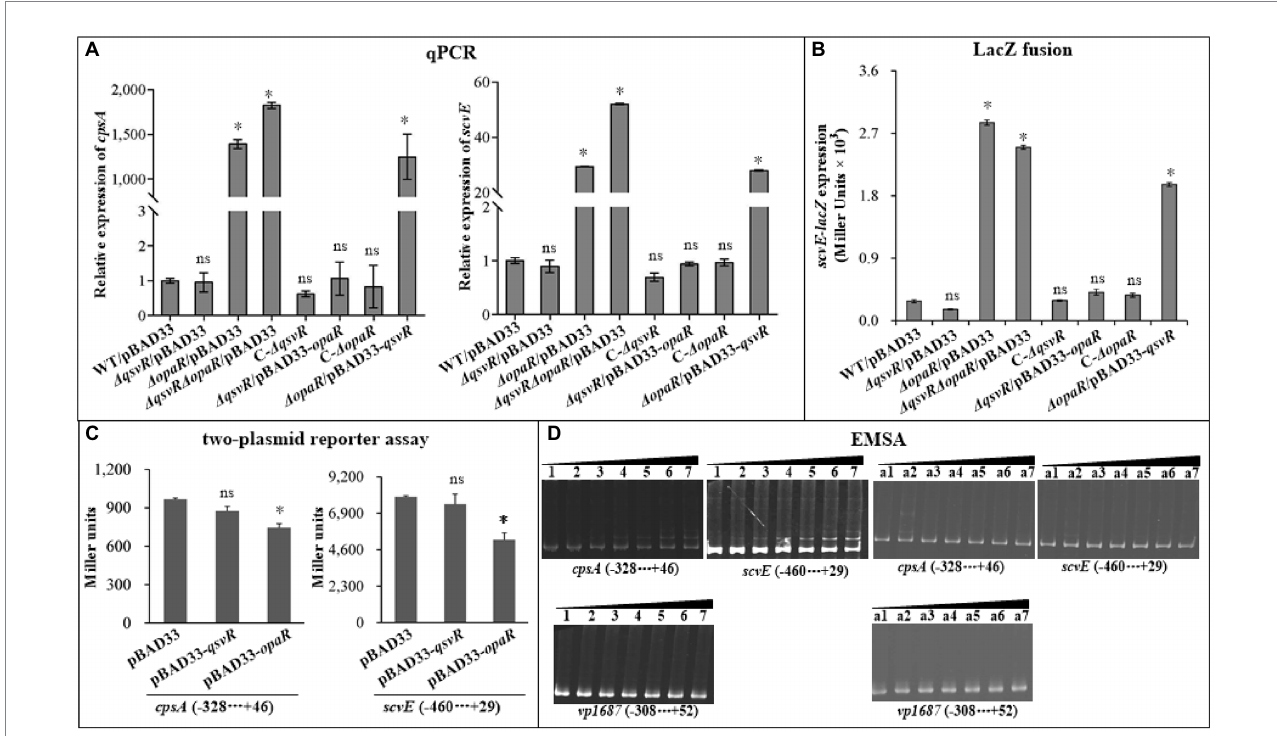
FIGURE 2 Regulation of cpsA and scvE by QsvR and OpaR. V. parahaemolyticus strains were cultured on HI plates, and bacterial cells were harvested after 6 h of incubation at 37 ° C. Negative and positive numbers indicate the nucleotide positions upstream and downstream of each target gene, respectively. The asterisks indicate statistical significances relative to WT/pBAD33 or E. coli 100 λ pir/pBAD33 ( p < 0.01). The ‘ns’ means no significant differences ( p > 0.01). (A) qPCR. The relative mRNA levels of cpsA and scvE were examined in the different V. parahaemolyticus strains. (B) LacZ fusion. The regulatory DNA region of each target gene was cloned into the pHRP309 vector and then transferred into V. parahaemolyticus strains to determine the promoter activities (represented by Miller units) in the cellular extracts. (C) Two-plasmid reporter assay. The complementary plasmid (pBAD33- qsvR or pBAD33- opaR ) or the empty pBAD33 vector and a recombinant lacZ plasmid were simultaneously introduced into E. coli 100 λ pir (Epicentre), and promoter activities (represented by Miller units) of each target gene in the cellular extracts were determined with a β -Galactosidase Enzyme Assay System (Promega, United States) according to the manufacturer’s instructions. (D) Electrophoretic mobility-shift assay (EMSA). The regulatory DNA region of each target gene was incubated with increasing amounts of purified His-QsvR or His-OpaR, and then subjected to 6% ( w / v ) polyacrylamide gel electrophoresis. The DNA bands were visualized by EB staining. Lanes 1, 2, 3, 4, 5, 6, and 7 contain 0, 0.4, 0.8, 1.2, 1.4, 2.0, and 2.4 pmol of His-OpaR, respectively. Lanes a1, a2, a3, a4, a5, a6, and a7 contain 0, 0.021, 0.042, 0.063, 0.083, 0.11, and 0.13 pmol of His-QsvR,